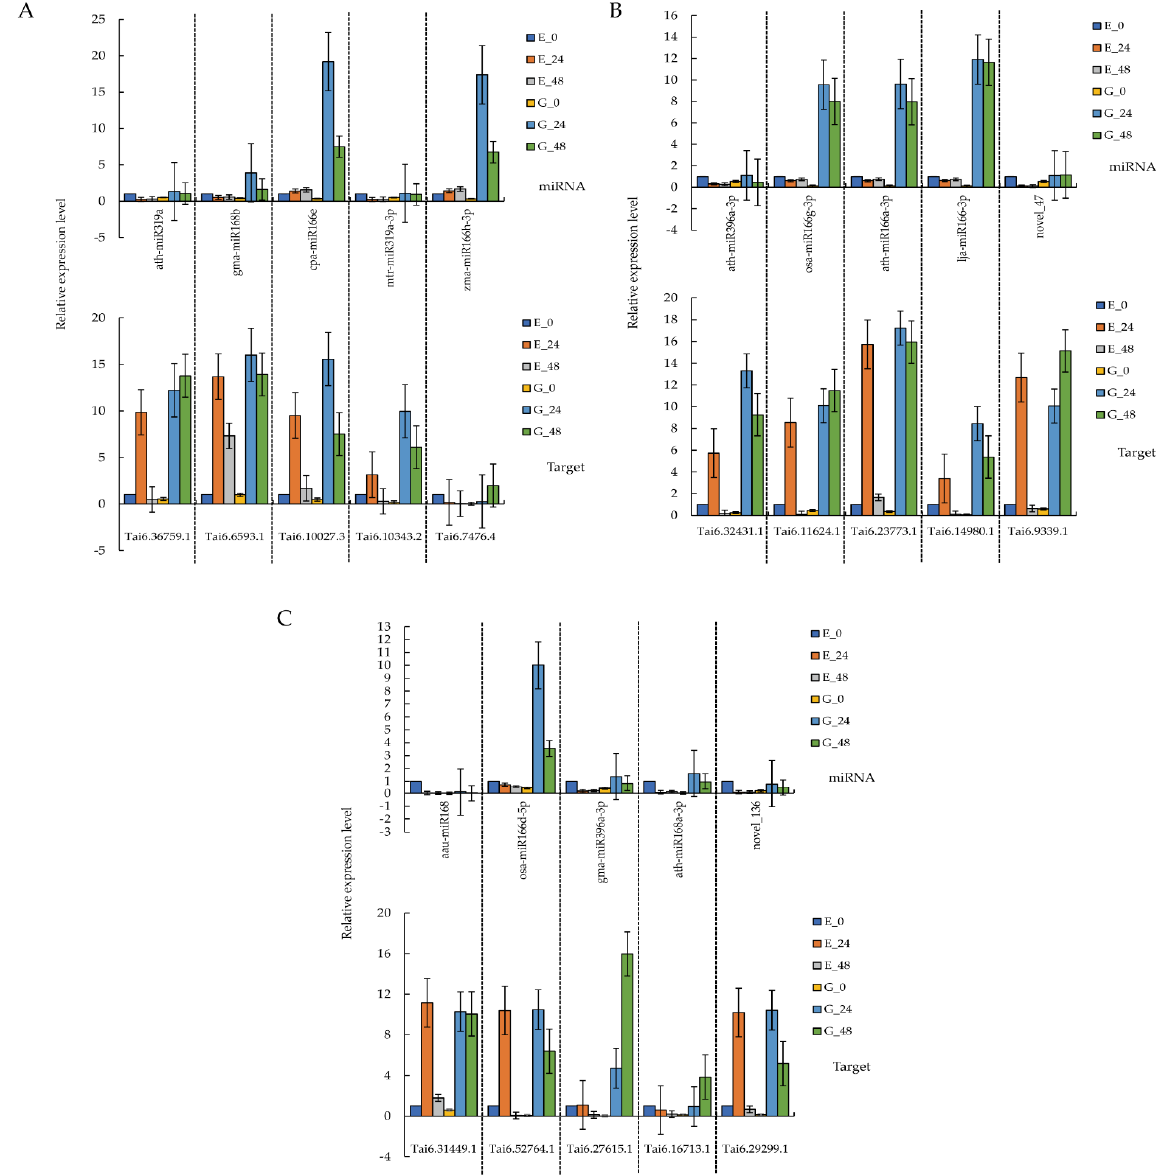
Figure 4. qRT-PCR analysis of miRNAs and target genes. ( A ) qRT-PCR analysis of ath − miR319a, gma − miR168b, cpa − miR166e, mtr − miR319a − 3p, zma − miR166h − 3p, and their target genes; ( B ) qRT-PCR analysis of ath − miR396a − 3p, osa − miR166g − 3p, ath − miR166a − 3p, lja − miR166 − 3p, novel_47, and their target genes; ( C ) qRT-PCR analysis of aau − miR168, osa − miR166d − 5p, gma − miR396a − 3p, ath − miR168a − 3p, novel_136, and their target genes.